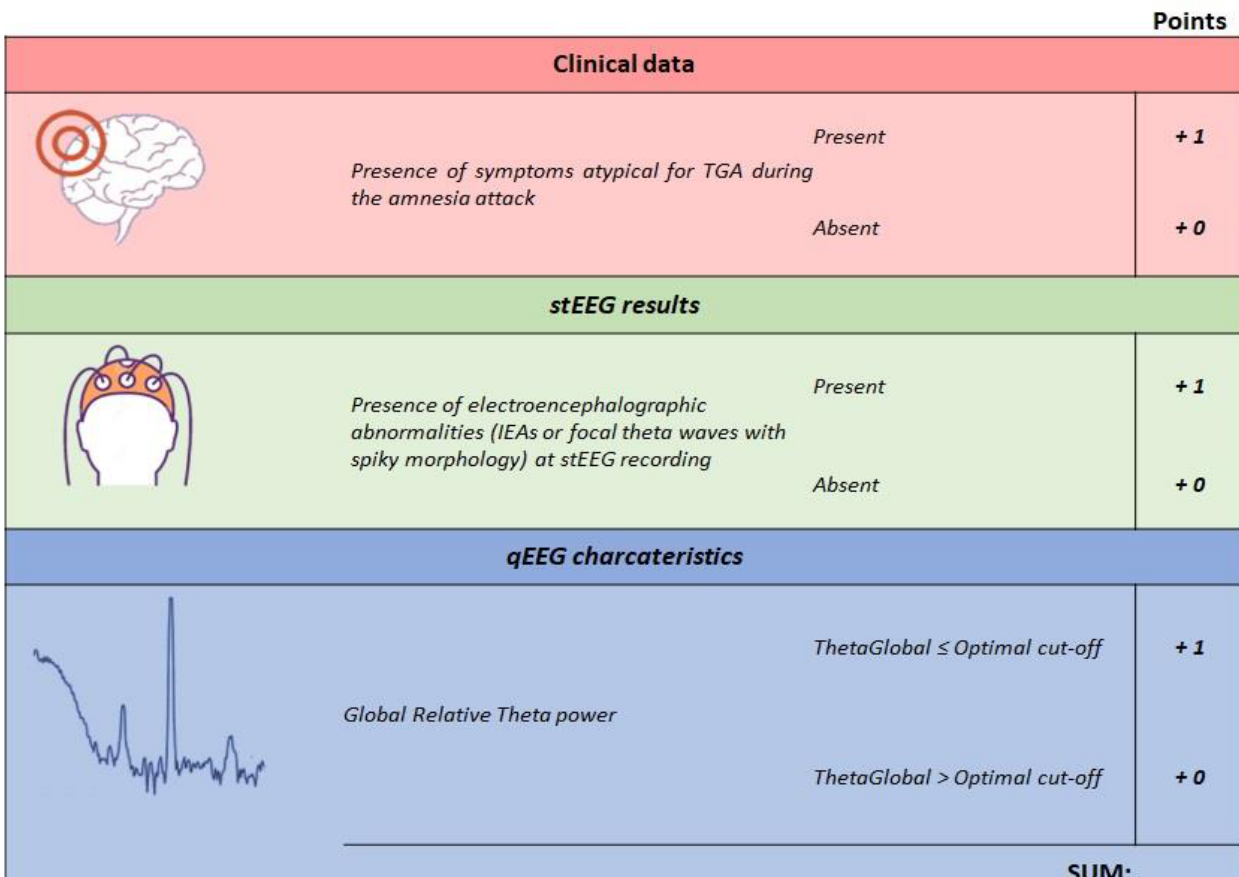
Figure 4. Construction of EPIMANE score.